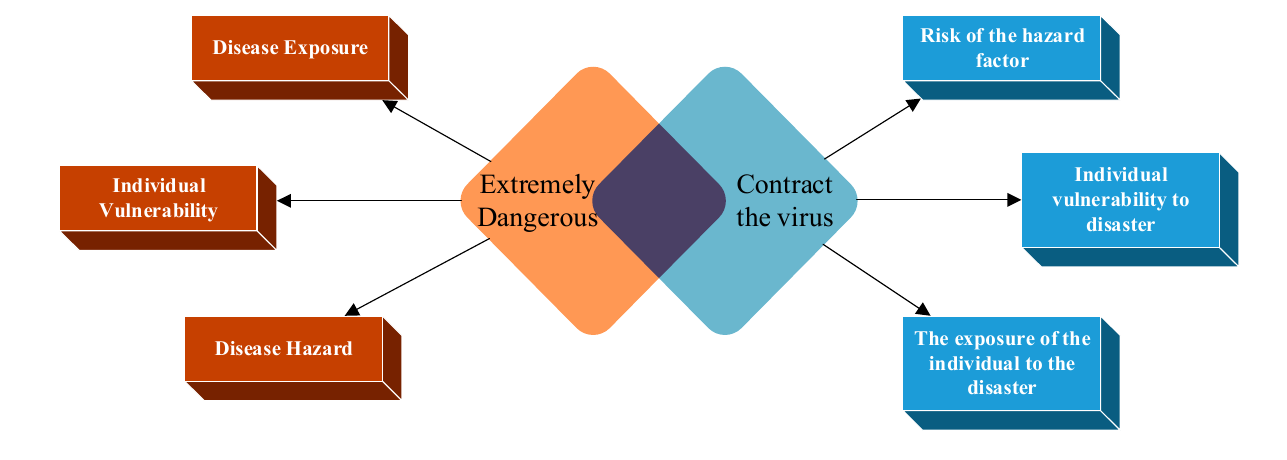
Figure 2. Residents’ primary infectious factors.